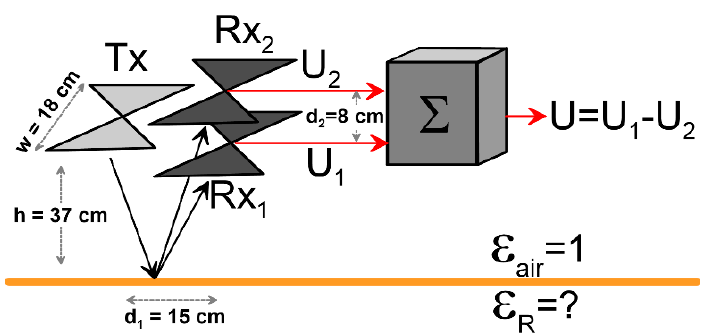
Figure 5. Schematic of 1-Tx, 2-Rx impulse GPR for simple measurement of surface reflection coefficient, with Rx differencing to suppress direct coupling signal.